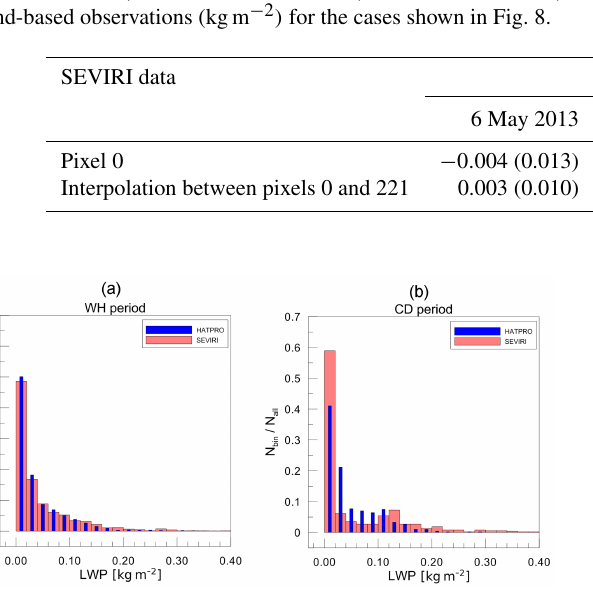
Figure 10. Seasonal frequency distribution of LWP for HATPRO and SEVIRI normalised with the total number of occurrence for the WH period (a) and the CD period (b)